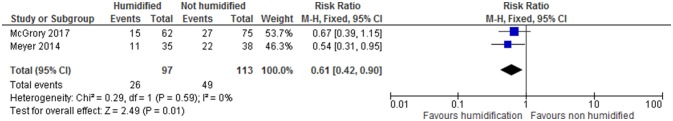
Admission temperature < 36°C.